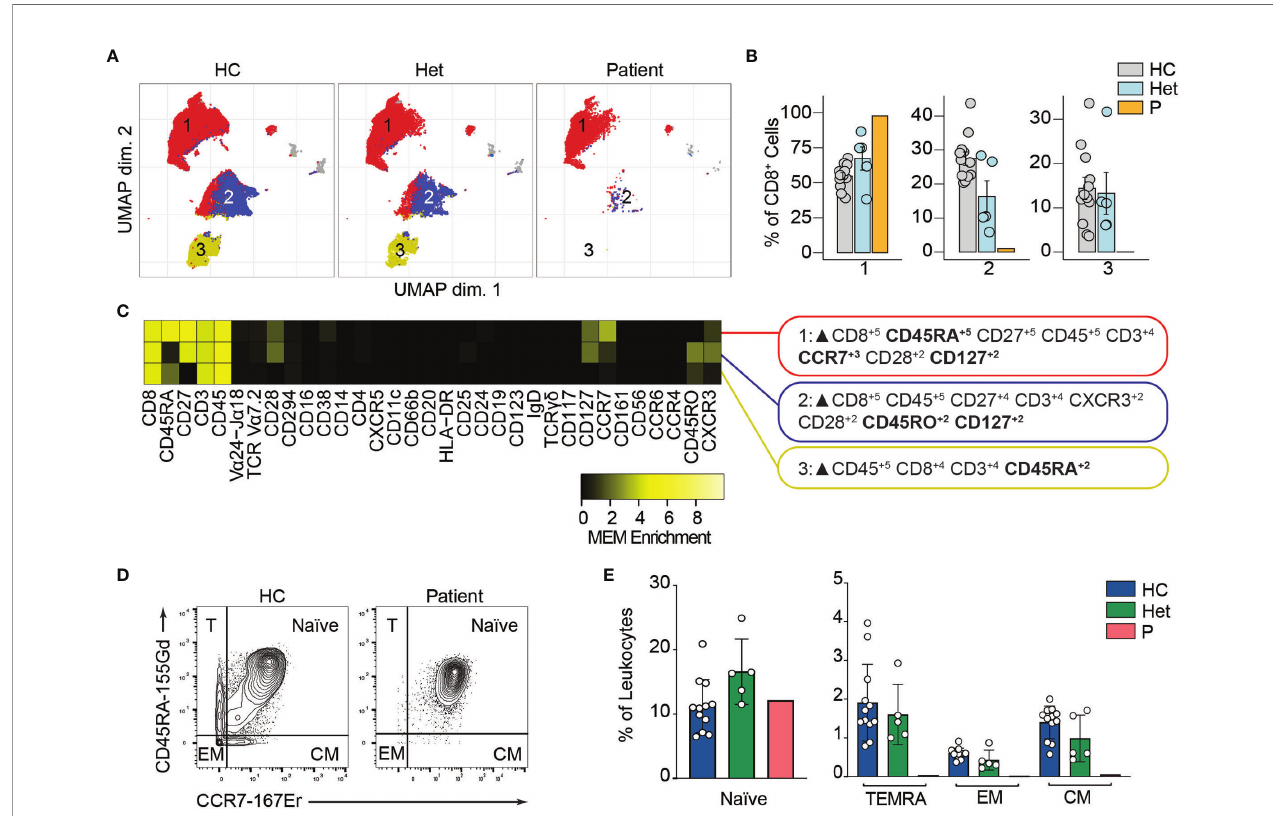
FIGURE 5 | CD8 + T cells immunophenotyping. (A) UMAP representation showing the CD8 + T population from . Each color represents a cluster obtained by unsupervised clustering using fl owSOM. 10,000 cells from healthy controls (HC), heterozygous carriers (Het) and the patient are represented. (B) Frequencies of the fl owSOM clusters highlighted in (A) as a percentage of total cells in the CD8 + T cells cluster from . (C) MEM heatmap and marker tags for the clusters shown in (A) . In bold are highlighted the markers differentially expressed between clusters. (D) CD45RA vs. CCR7 CD8 + cell gating example for a representative healthy control (HC) and the patient. Detailed gating strategy is shown in Figure S2 . (E) Frequencies of Naïve, TEMRA, effector memory (EM) and central memory (CM) CD8 + T cells in healthy controls (HC), heterozygous carrier (Het), and patient as a percentage of leukocytes obtained by manual gating in